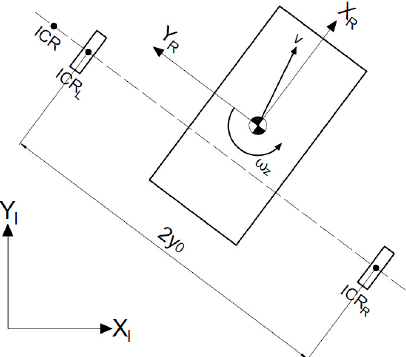
Figure 3. The replacement model for symmetrical skid-steer robot.